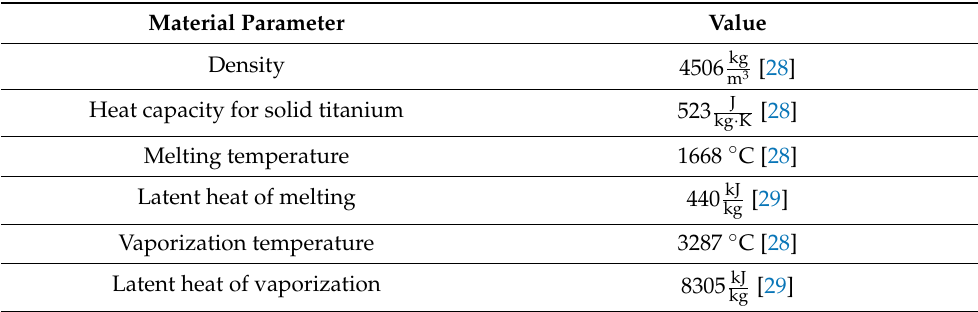
Table 2. Material properties of titanium, as published in [28,29] used for the calculation of the volume-specific enthalpy h V for heating and vaporization.